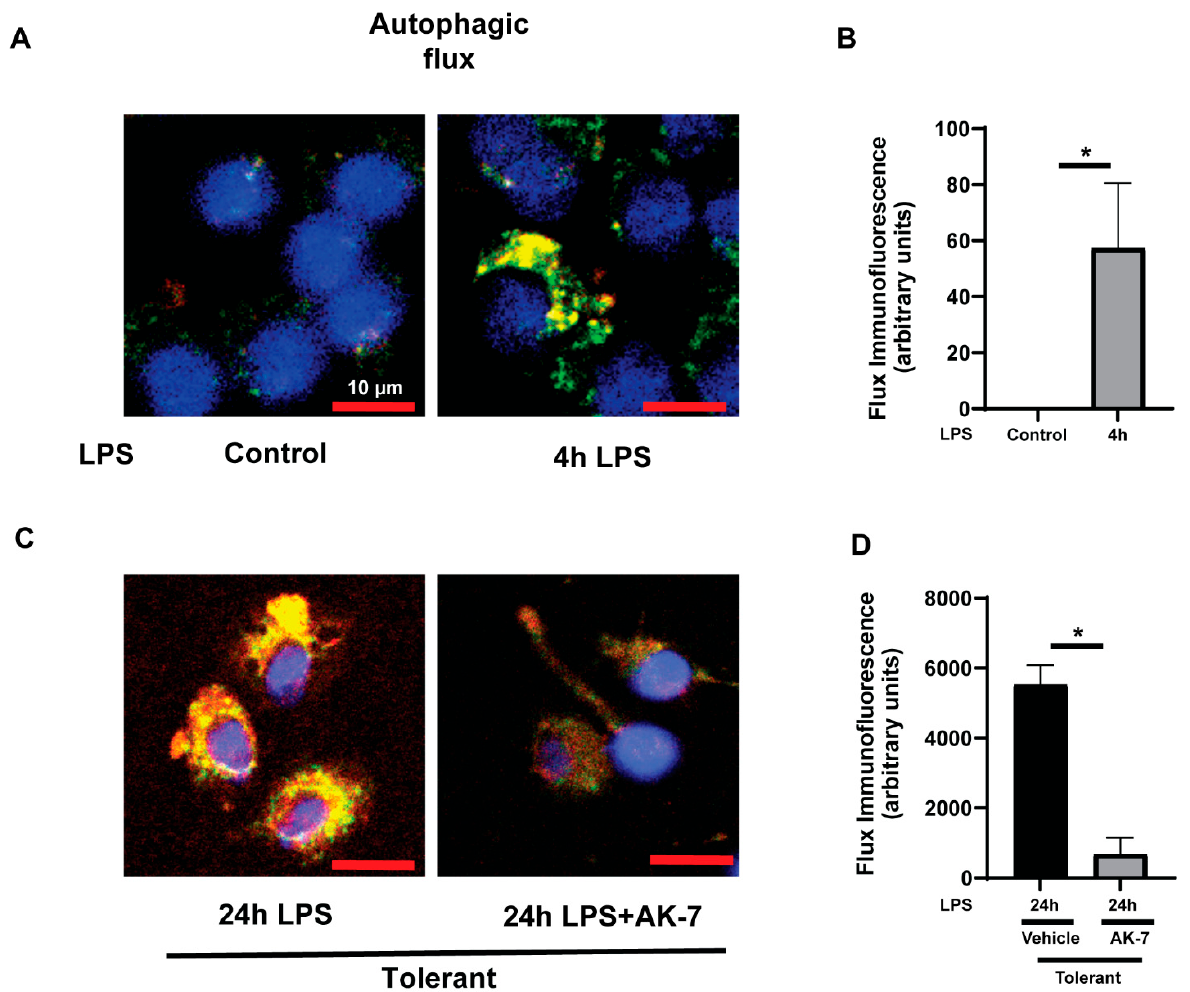
Figure 8. SIRT2 inhibitor AK7 increases autophagic clearance in the tolerant macrophages. Stearic acid (free fatty acid: FFA)-exposed sensitive and tolerant RAW264.7 cell macrophages (RAW) were stimulated with or without LPS as indicated. ( A ) Representative images of autophagosome formation (yellow puncta) with mRFP-GFP-LC3 transduction in FFA-exposed sensitive RAW cells. ( B ) Fluorescence quantification of mRFP/GFP fluorescence in FFA-exposed RAW cells in control (without LPS) and LPS. ( C ) Representative images of autophagosome formation (yellow puncta) with mRFP-GFP-LC3 transduction in FFA-exposed tolerant RAW cells in the presence or absence of AK-7. ( D ) Fluorescence quantification of mRFP/GFP fluorescence in tolerant RAW cells in the presence or absence of AK-7. Autophagosome formation indicated by merged GFP and RFP fluorescence, indicated by yellow-puncta. * p < 0.05.